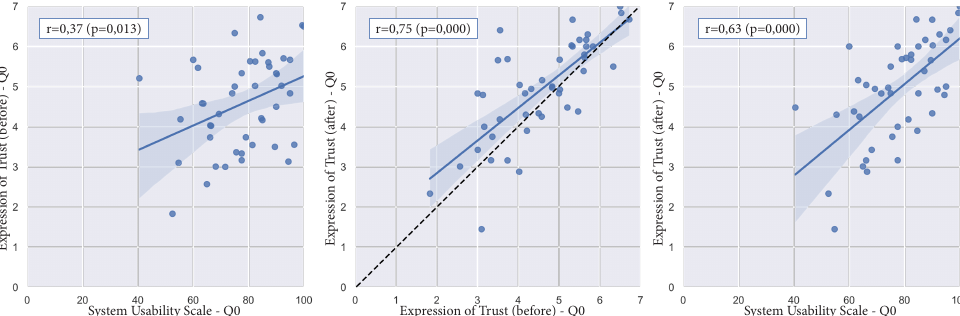
Figure 10. Pearson correlations for the combination of the accumulated questions Q0 with best fitted line. ( r ... Pearson correlation coefficient, p ... significance of the